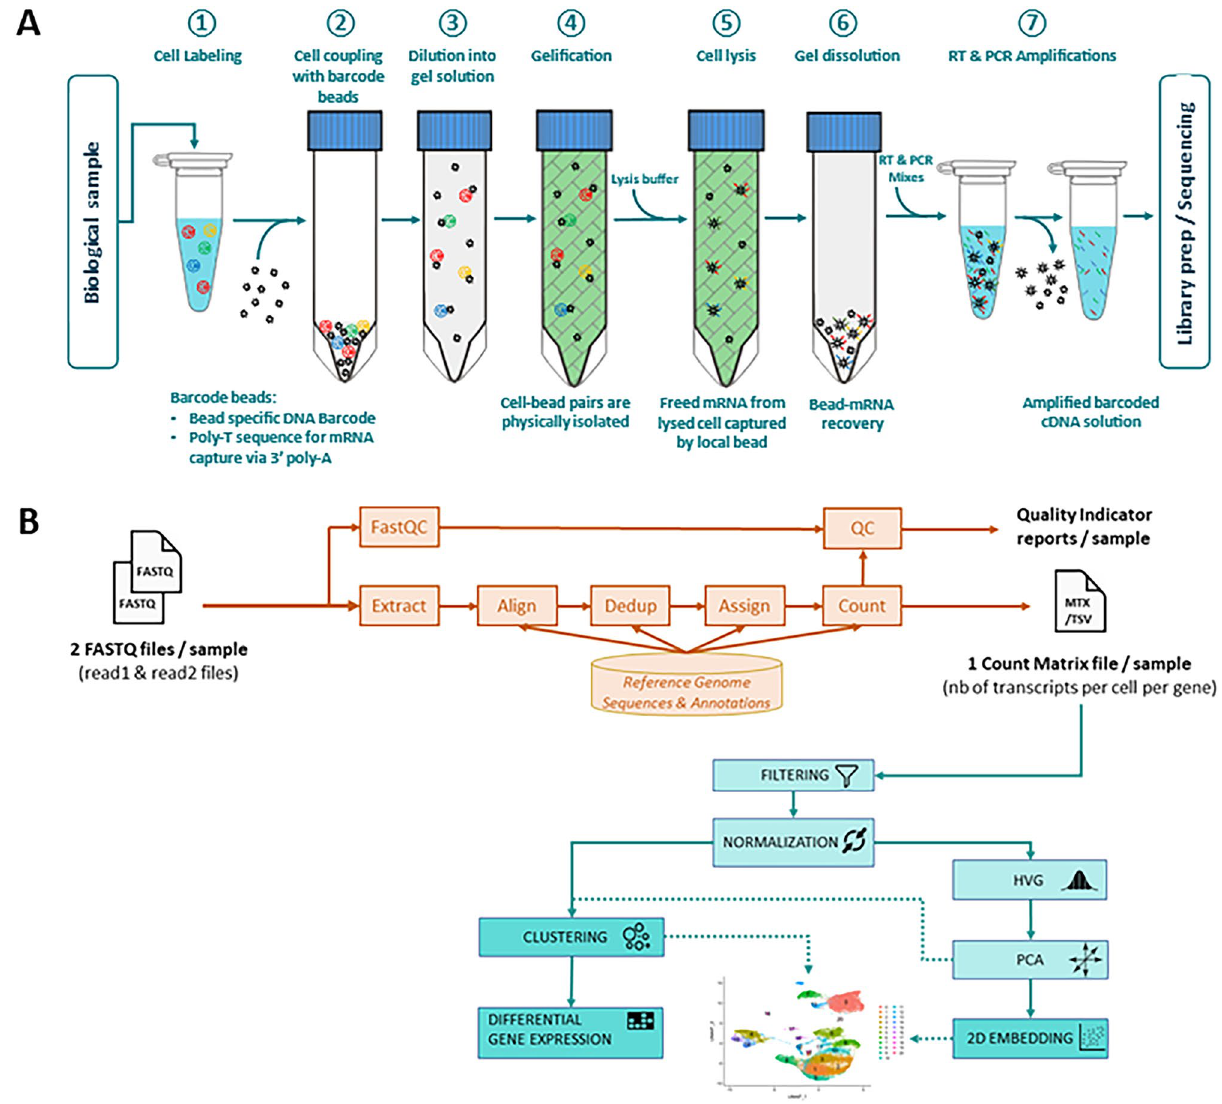
Figure 1. Sample preparation workflow and data analysis pipeline. ( A ) RevGel-seq workflow steps for sample preparation to characterize scRNA-seq. Barcoded beads and cells are attached via a bifunctional chemical linker. These complexes are dispersed in the hydrogel in the liquid state and immobilized upon gelation. Following cell lysis, RNA molecules are captured on the barcodes. After reverse transcription, barcoded cDNAs are PCR- amplified. Further details are presented in “Methods”. ( B ) Workflow of the end-to-end data processing pipeline integrated in the Cytonaut platform. The pre-processing phase inputs the raw sequencing data (FASTQ files) and outputs quality indicators and count matrices, followed by the post-processing phase that inputs the count matrices to perform 2D embedding, cell clustering and differential gene expression. The Cytonaut Rover module enables interactive data visualization. Additional details in